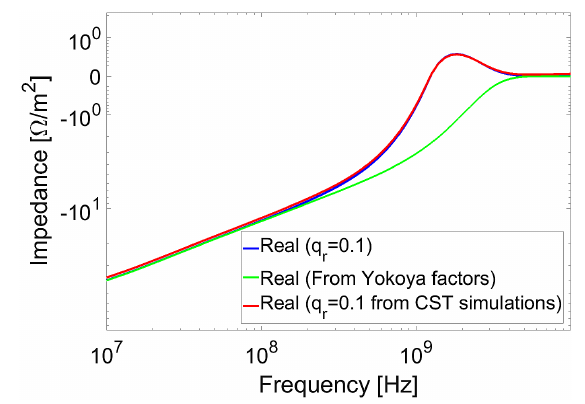
FIG. 6. Real part of the horizontal detuning impedance per unit of length as given by Eq. (30) for q r ¼ 0 . 1 (blue curve), compared with IW2D by using the Yokoya factor (green curve). The beam pipe has three layers of thicknesses 0.4 mm, 3 mm, infinity and respective conductivities of 7 . 7 × 10 5 S = m, 1 × 10 4 S = m, and zero (vacuum